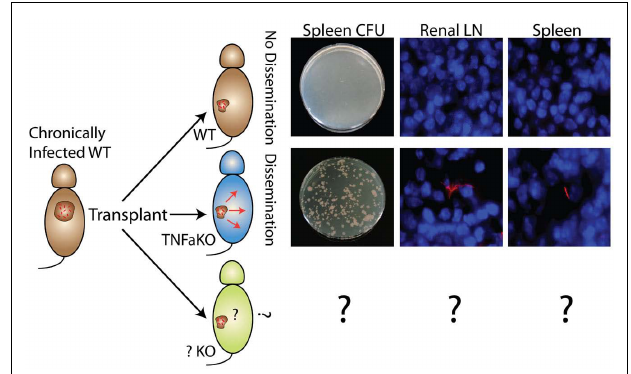
FIGURE 5 | Non-expanding BCG fromWT chronic granulomas can be induced to disseminate and expand after transplantation intoTNF α KO, but notWT, recipients. Disseminated bacteria are measured by CFU and fluorescent microscopy of recipient target organs such as spleen and renal lymph node.These experiments highlight the system’s potential as a new model of bacterial dissemination to study host protection factors (bottom), bacteria mutants, and new